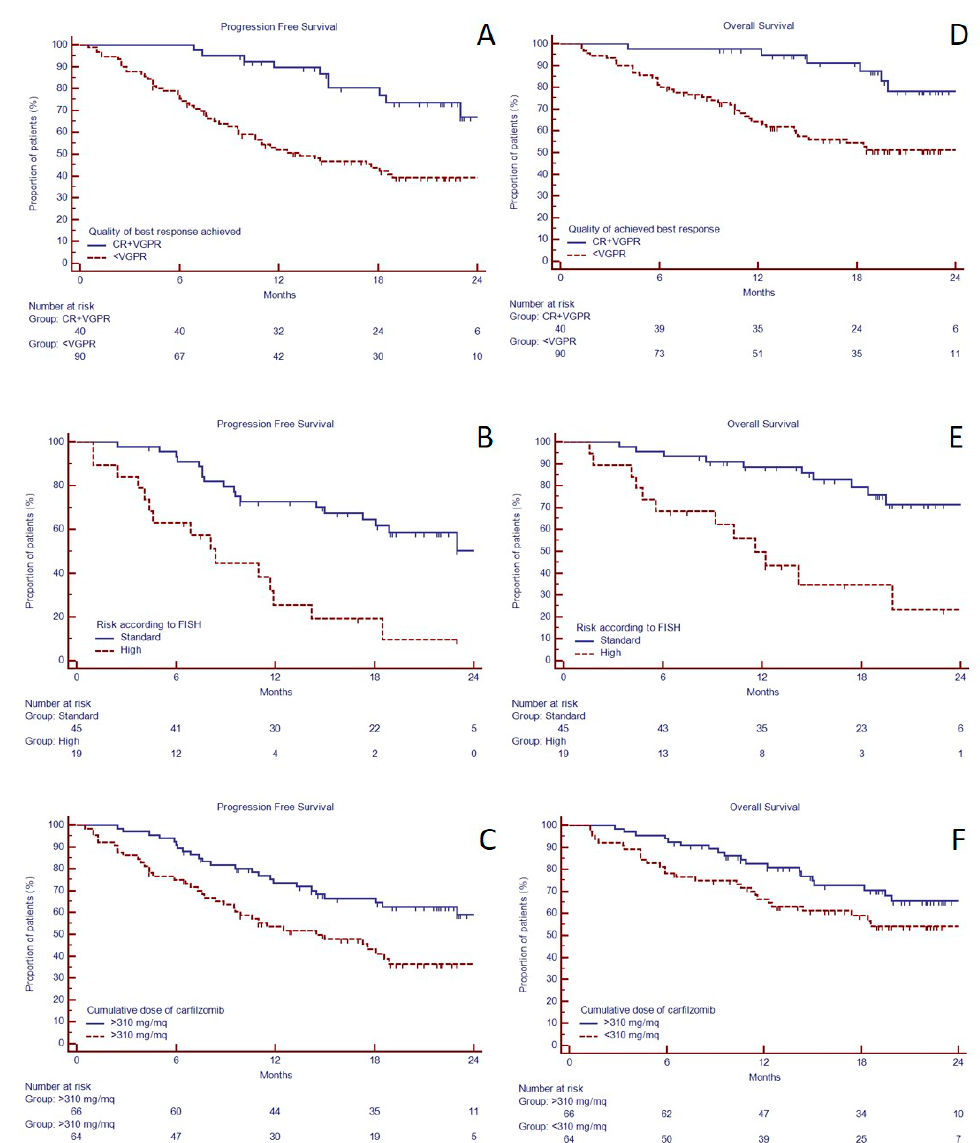
Figure 2. Progression free survival and overall survival in 130 RRMM candidates to KRd as salvage regimen in a real-life approach. Progression free survival in 130 RRMM candidates to KRd as salvage regimen in a real-life approach based on response achieved ( A ), FISH risk (data available for only 64 patients) ( B) , and cumulative dose of carfilzomib received ( C ). Overall survival in 130 RRMM candidates to KRd as salvage regimen in a real-life approach based on response achieved ( D ), FISH risk (data available for only 64 patients) ( E ), and cumulative dose of carfilzomib received ( F ). Median cumulative carfilzomib received dose was 4000 mg/m 2 . Since all patients had received at least two KRd cycles, we evaluated the prognostic significance of carfilzomib cumulative dose limited to the first two cycles and we found that patients who received a cumulative dose of at least 310 mg/m 2 (equivalent to full-dose) in the first two cycles, had longer median PFS (27.0 vs. 14.5 months, HR 1.99, 95% C.I. 1.21–3.31, p = 0.006, Figure 2C). However, median OS was not reached in both groups (Figure 2D), and there was not a statistically significant difference.